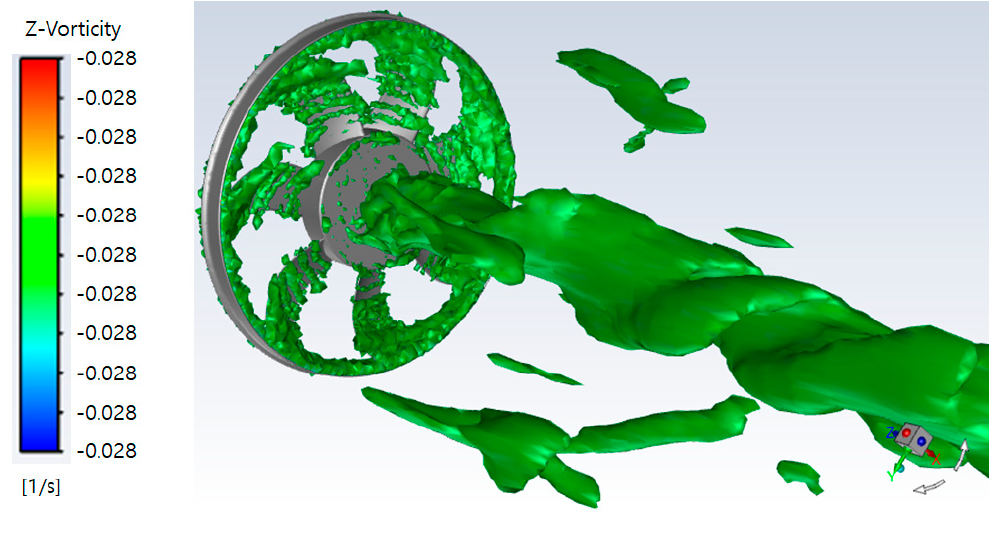
Figure 6. Iso-Surface of instantaneous vorticity magnitude at T* = 9.2.